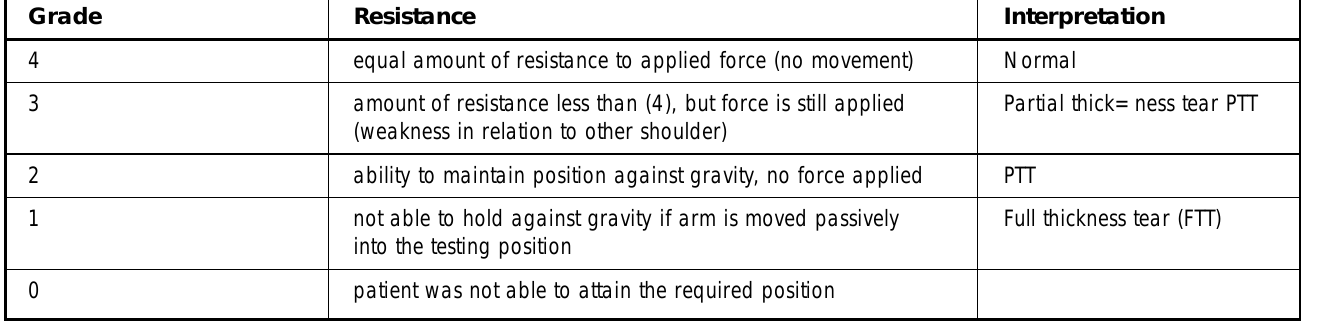
Table 2: Grading of manual muscle tests according to muscle strength adapted from Itoi et al.